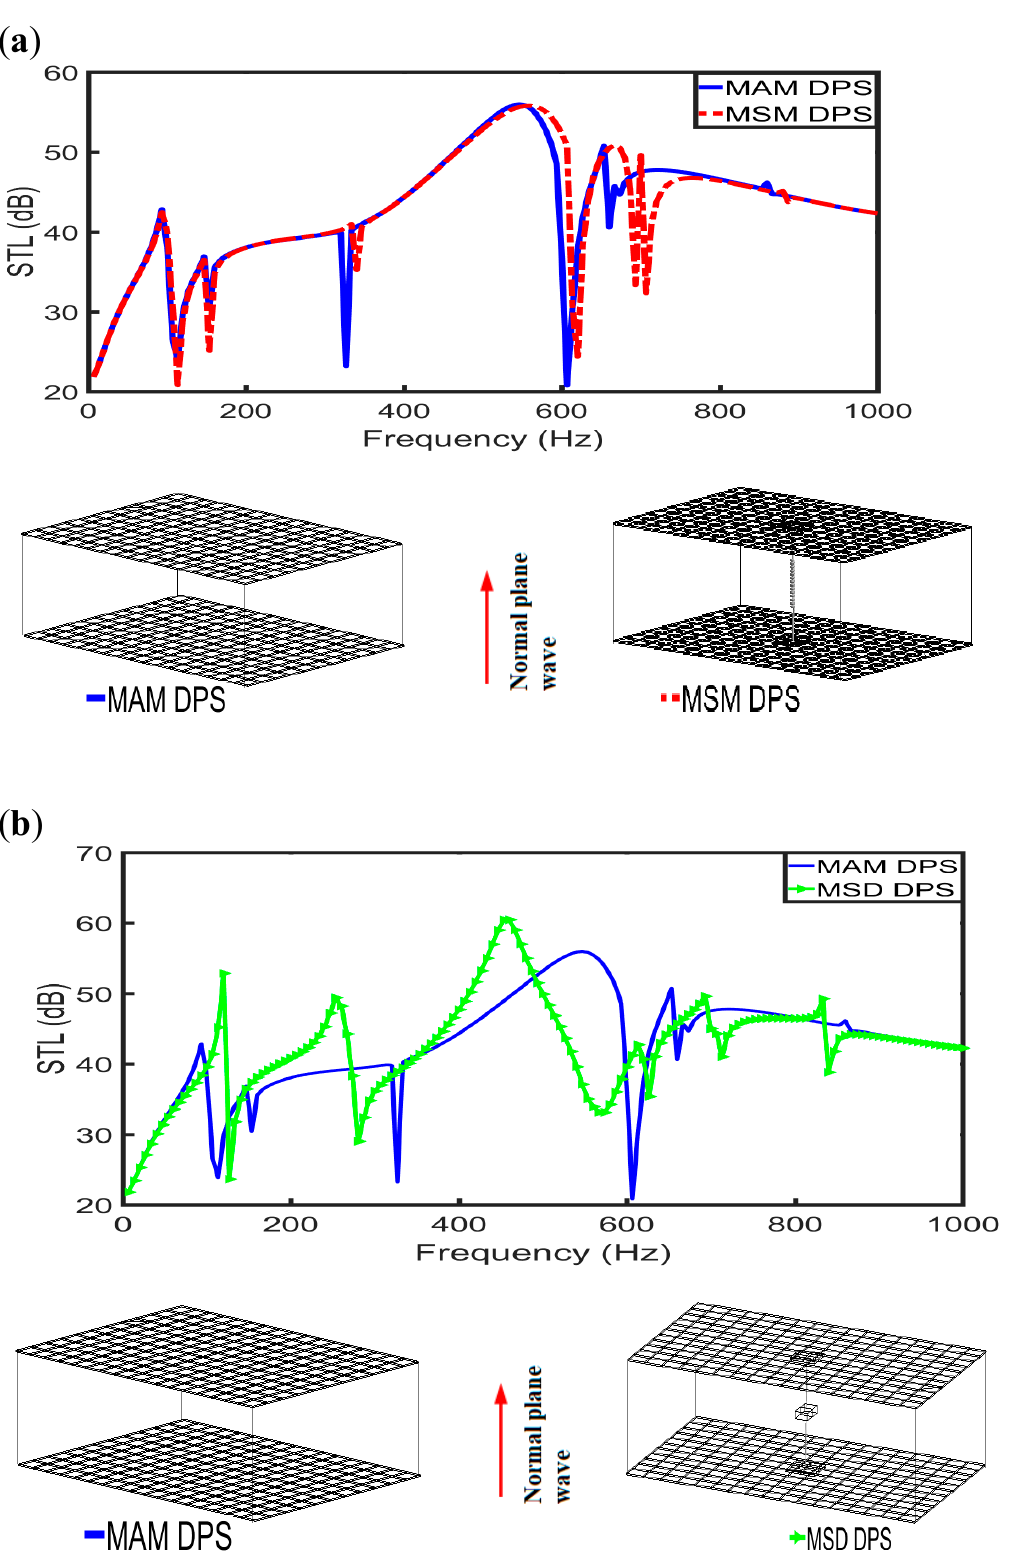
Figure 3. Result comparison of double panels and their corresponding finite element mesh configurations for the enclosed air cavity of ( a ) MAM and mass–spring–mass (MSM), ( b ) MAM and MSD systems.